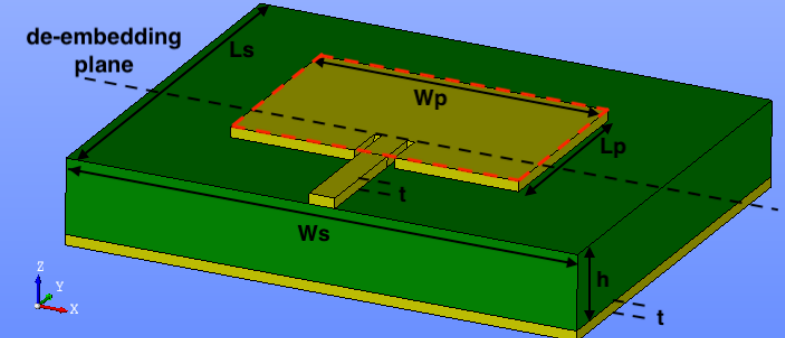
Figure 9. Terahertz rectangular patch antenna with W p = 83.33 µ m, L p = 54.83 µ m, t = 3 µ m, printed on a lossless polyimide substrate with dimensions W s = 147.83 µ m, L s = 119.33 µ m, h = 21.5 µ m.